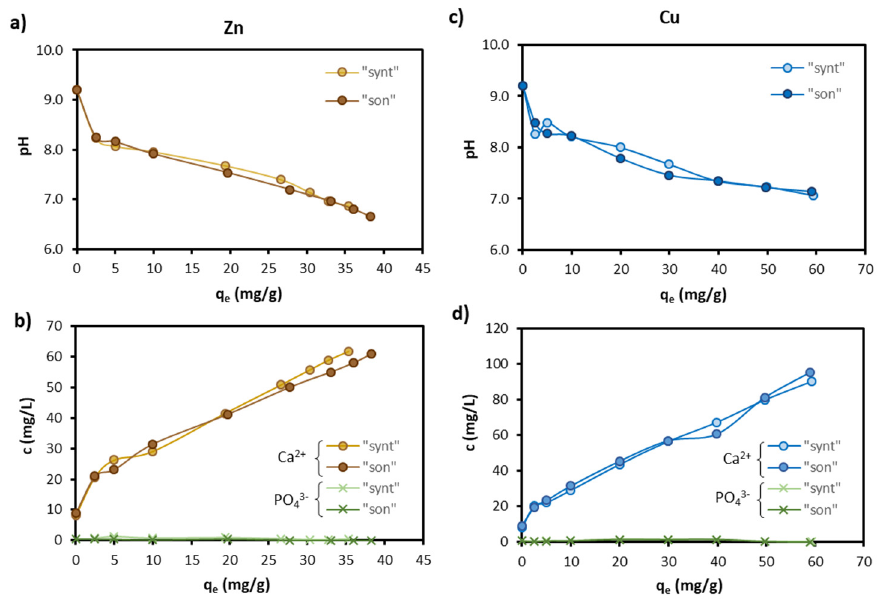
Figure 7. Variations in pH and Ca 2+ and PO 43 − concentrations following Zn sorption ( a , b , respec- tively) and Cu ( c , d , respectively) sorption.